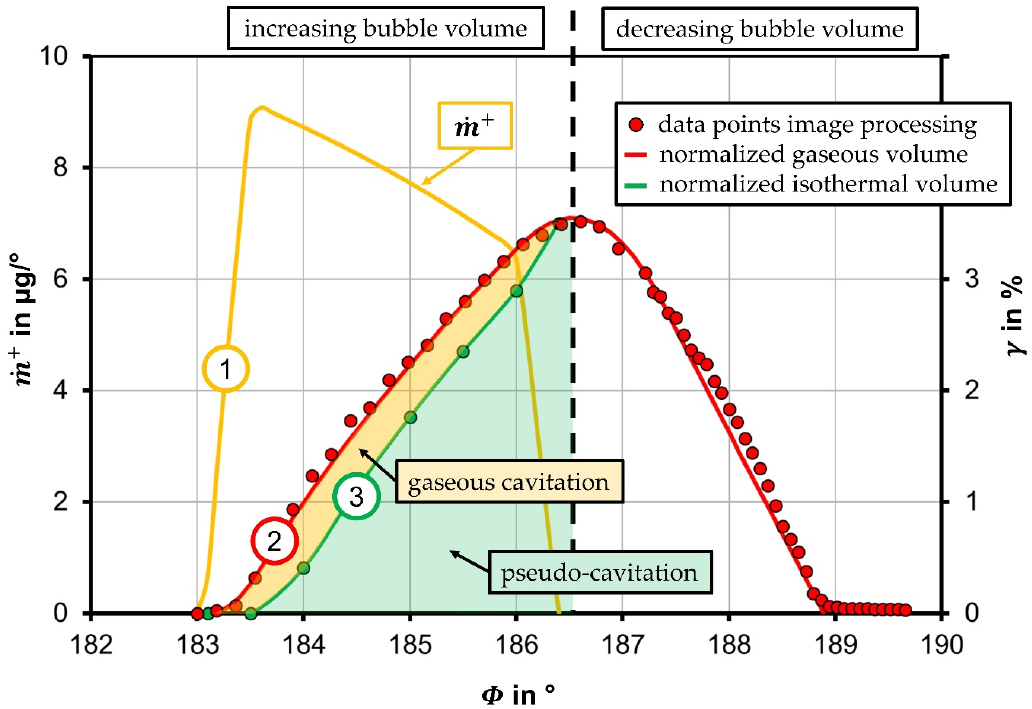
Figure 16. Description of the process of deducing the mass flow rate for bubble growth after initiation of transient radial displacement, fluid: paraffin containing 100% dissolved air.